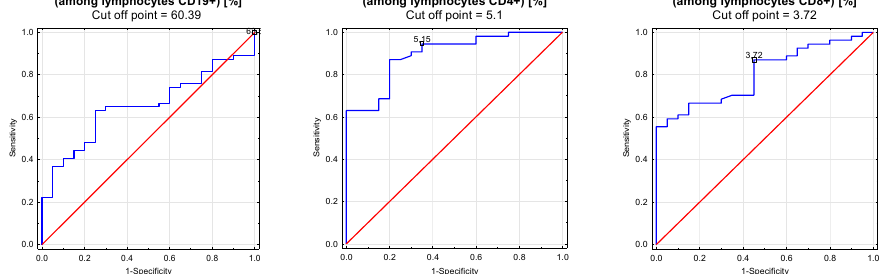
Figure 2. Receiver operating characteristic (ROC) curve analysis showing the sensitivity and specificity of CD200 expression in EMS patients for CD4+/CD8+/CD200+ T lymphocyte frequencies (%) and CD19+/CD200 B lymphocyte frequencies (%).